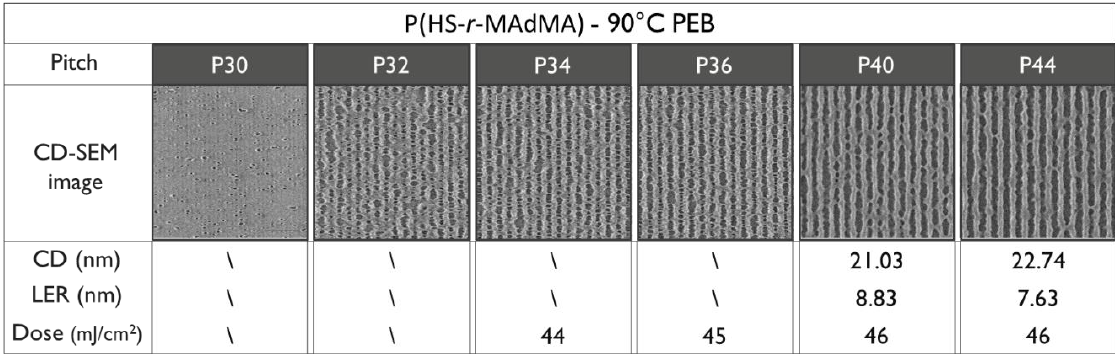
Figure 10. Patterning performance of the P(HS- r -MAdMA) polymer-based resist at 90 °C PEB.